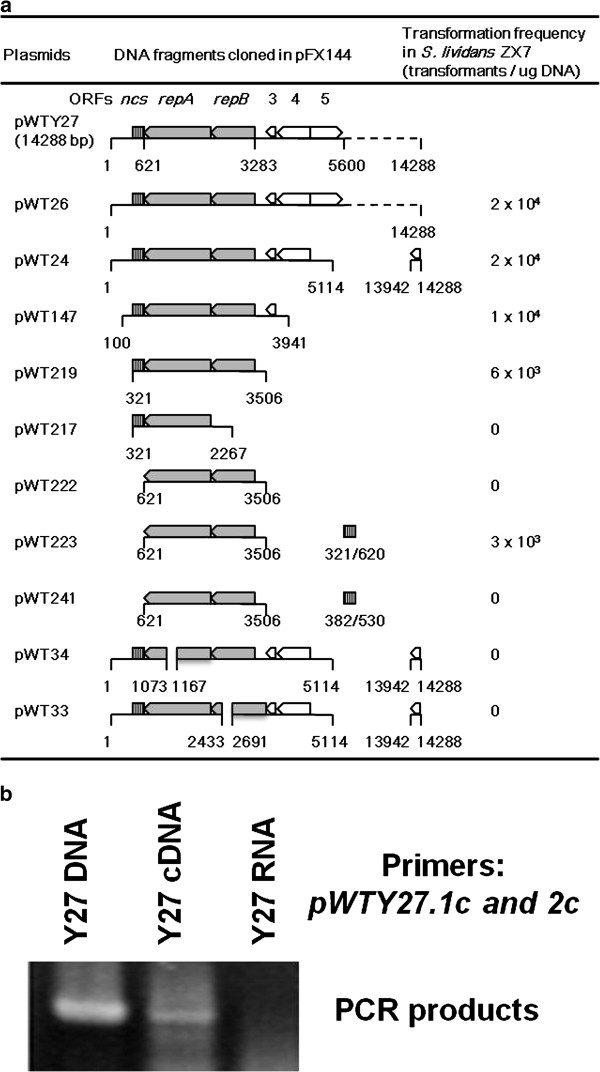
Identification of a pWTY27 locus required for replication inStreptomyces lividans. (a). Identification of a replication locus. Plasmids were constructed in E. coli (see Methods and Table 1), and introduced by transformation into S. lividans ZX7. Positions of these cloned fragments on pWTY27 and transformation frequencies are shown. The ncs is indicated by striped boxes, relevant genes by open arrowheads and the two replication genes by filled arrowheads. (b). RT-PCR of a transcript overlapping the consecutive replication genes. RNA of strain Y27 was isolated and reverse-transcribed into cDNA. The cDNA, RNA and Y27 genomic DNA were used as templates for PCR amplification and their products were electrophoresed in 1.5% agarose gel at 20 V/cm for 1 h.